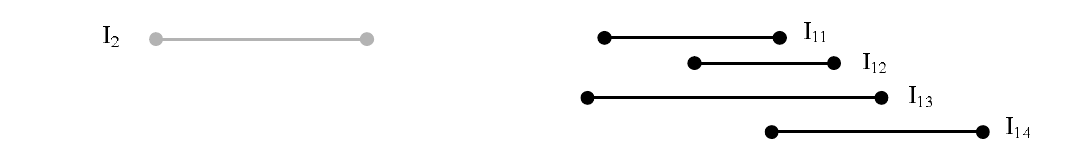
Figure 2. Efficient probing example.